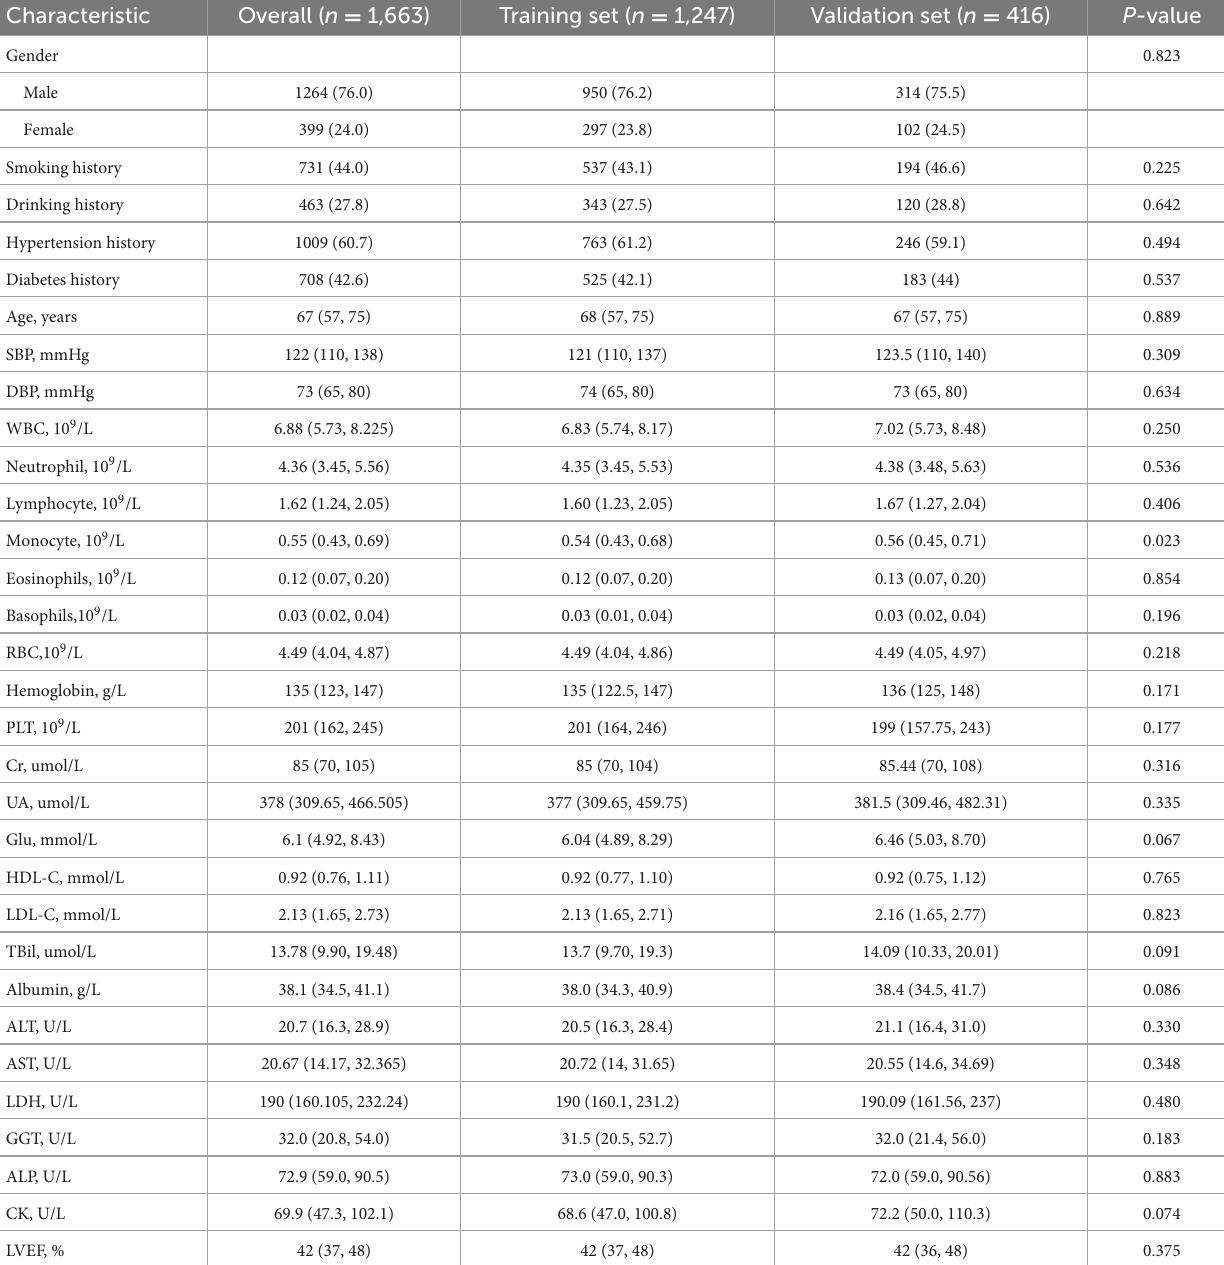
TABLE 1 Characteristics of the participants in different